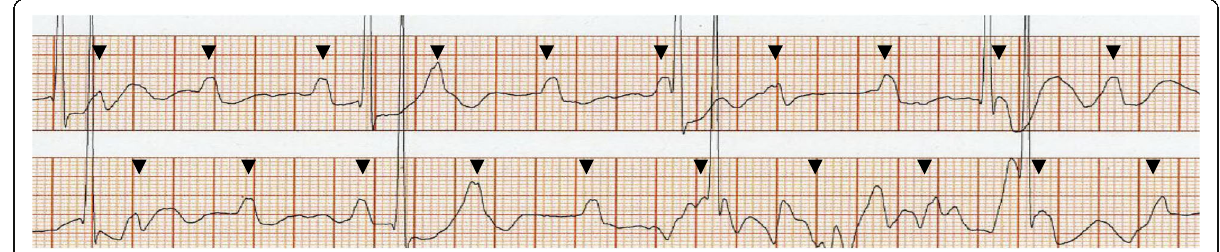
Fig. 2 Intraoperative monitor electrocardiogram following induction of general anesthesia. The traces show complete atrioventricular block with junctional escape rhythm of approximately 30 – 40 beats per minute. The P waves ( marked ) were completely dissociated from the QRS complexes. Artifacts most likely due to poor electrode contact with the skin caused the noisy baseline in this